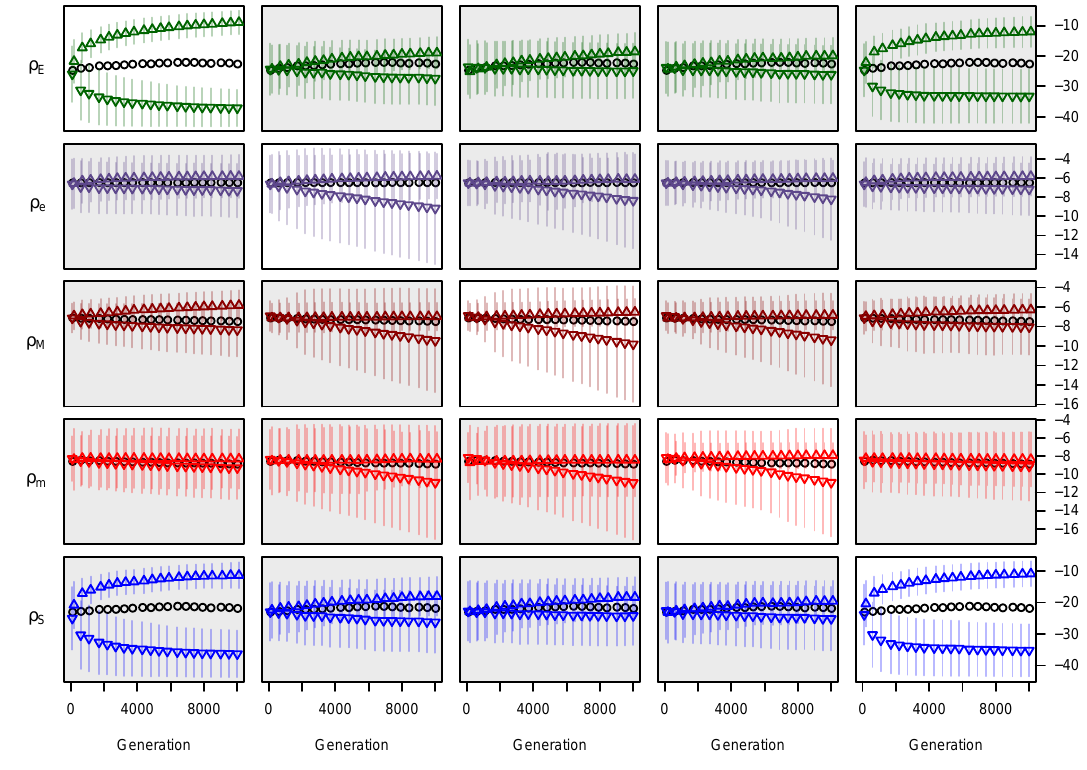
Figure 3 – The evolution of all five robustness indicators under direct and indirect se- lection was recorded for 10,000 generations in individual-based simulations. The panels show the average and standard deviation of robustness over 100 replicated simulations. The control simulations (black circles) correspond to stabilizing selection on gene expres- sion only (no direct selection on robustness). Colored symbols correspond to simulations in which robustness indicators were selected up or down (upward or downward trian- gles), colors correspond to the observed indicator, columns indicate which indicator was selected (diagonal panels: direct selection, off-diagonal panels: indirect